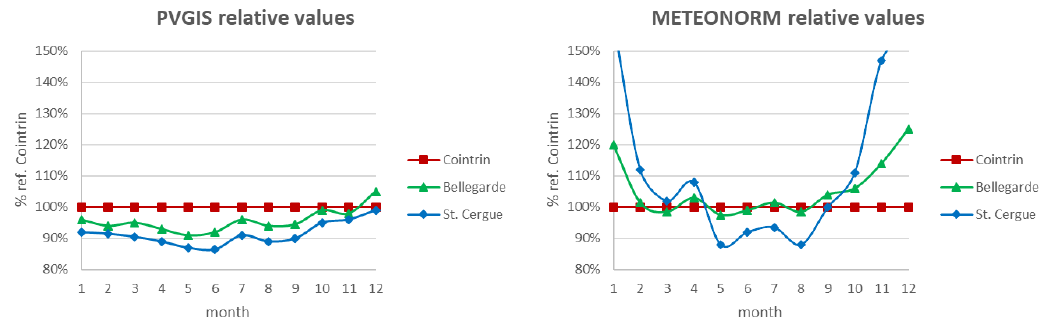
Figure A2. Comparison between PVGIS ( left ) and Meteonorm ® ( right ) in terms of relative irradiation.